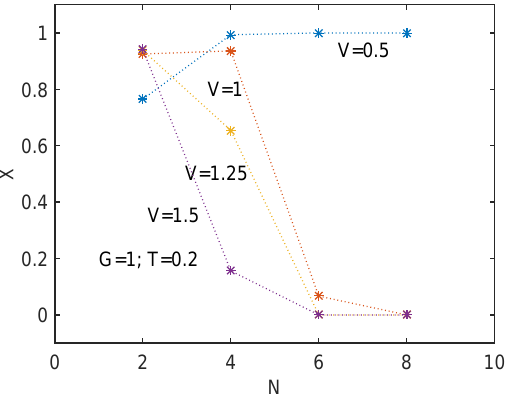
Figure 5. The N dependence. Superconductivity indicator X versus N for several V values. We have T = 0.2. The pairing effects’ intensity falls or grows as N grows, according to how large V is—more precisely, according to whether it is greater or smaller than V crit .